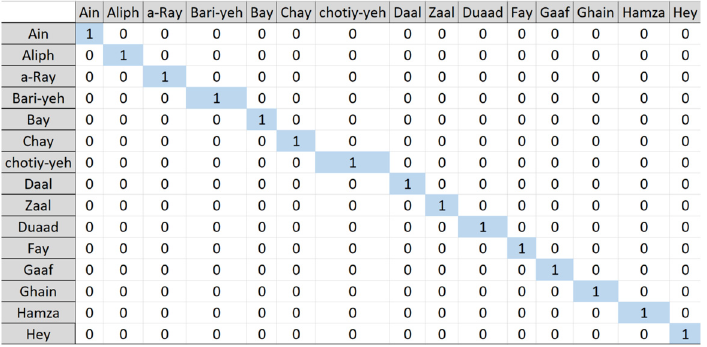
Figure 25. Confusion matrix of letters within PSL dataset (set 2).